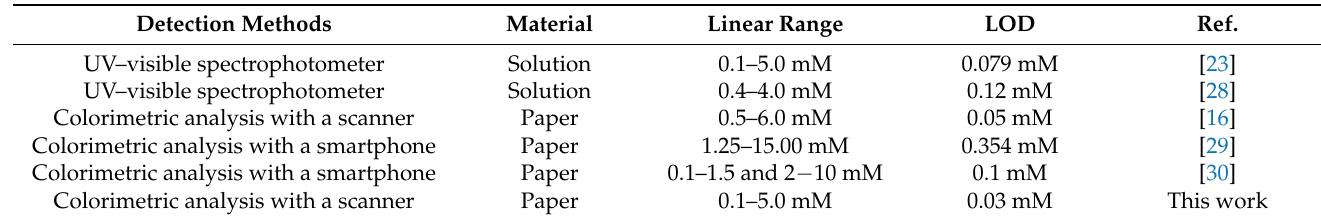
Table 2. Determination of glucose using paper device and compared the results with other reported methods.